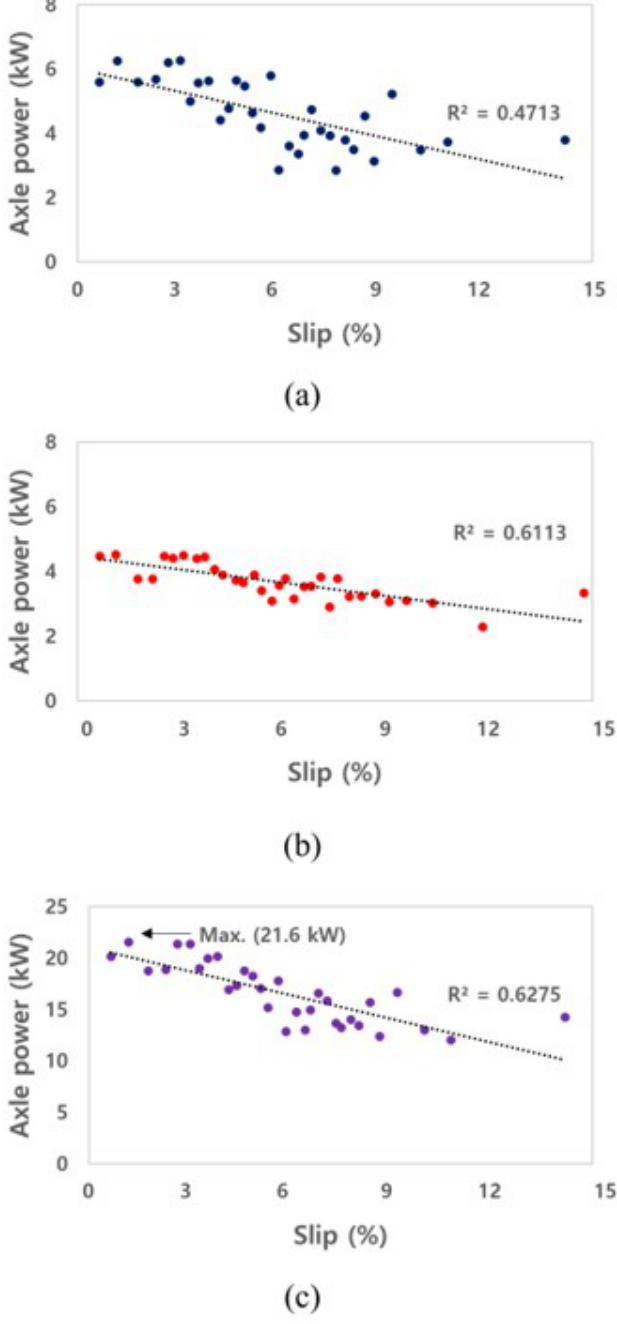
Figure 9. Results of axle power as slip for the electric AWD tractor during traction test: ( a ) a left axle, ( b ) a right axle, and ( c ) sum of all axles.